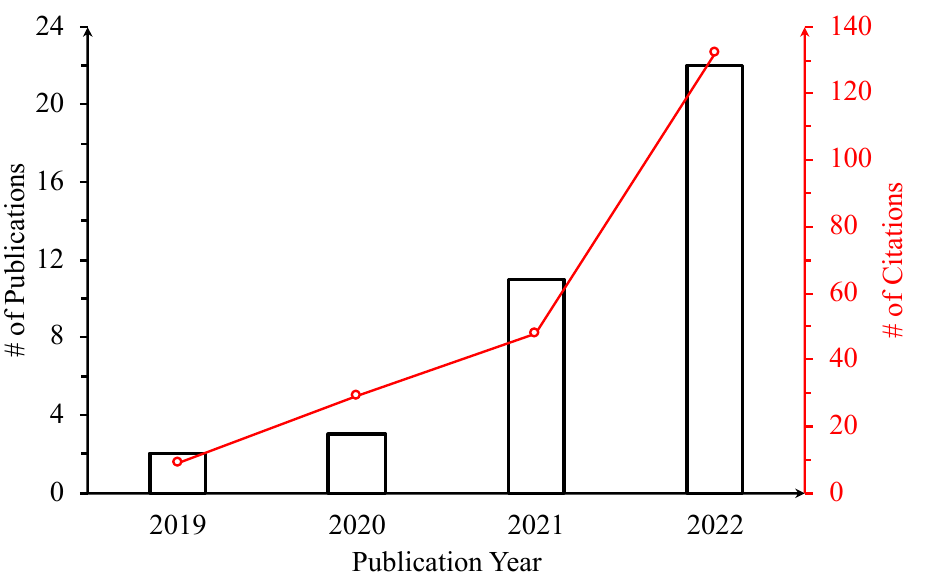
Figure 14. Yearly distribution of published journal articles indexed in Scopus and Web of Science with the corresponding citations from 2019 to 2022.